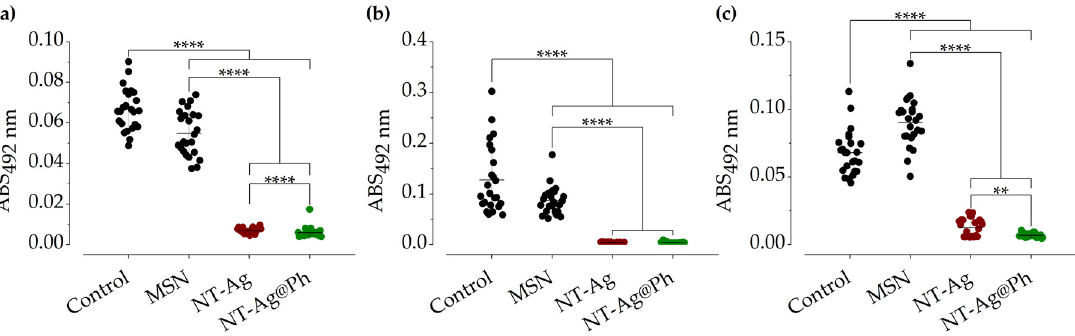
Figure 4. Inhibition of biofilm development of ATCC27853 ( a ), PA8 ( b ), and PA13 ( c ) in the presence of MSN (as a control, black), NT-Ag (garnet), and NT-Ag@Ph (green) at 125 µg/mL. ** p < 0.01, **** p < 0.0001 according to Mann–Whitney and Kruskal–Wallis tests.